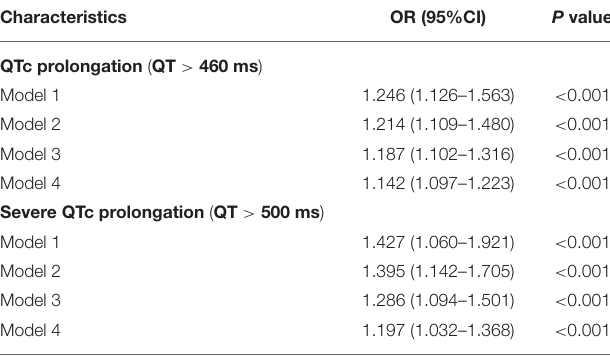
TABLE 2 | Association between QTc prolongation and single vs. twin pregnancies. TABLE 3 | Compared of demographic and clinical characteristics between QTc-normal and QTc-prolongation